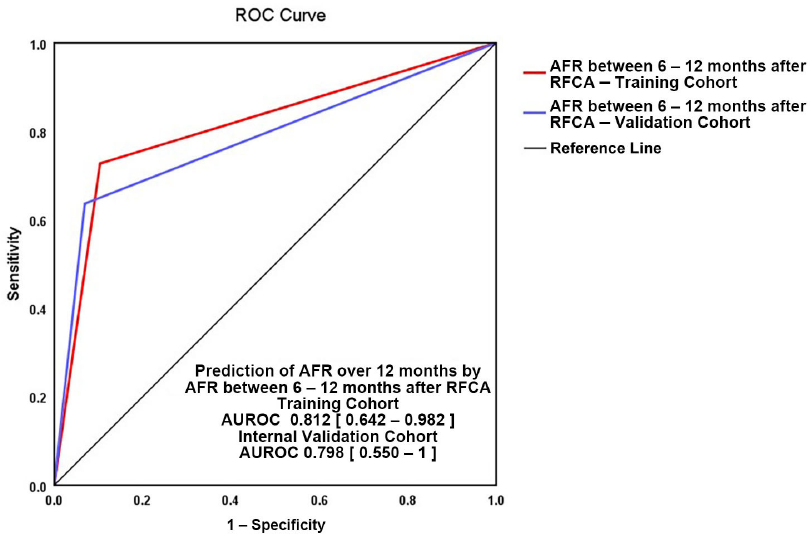
Figure 5. Validation of “AFR between 6–12 months” for atrial fibrillation recurrence (AFR) prediction after 12 months from RFCA. Red line—study group, blue line—validation subgroup.